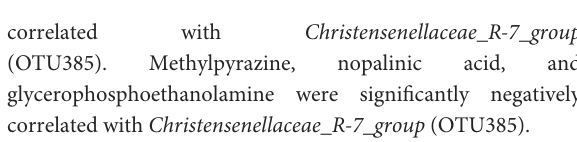
Clostridium_sensu_stricto_1 (OTU16, OTU474,